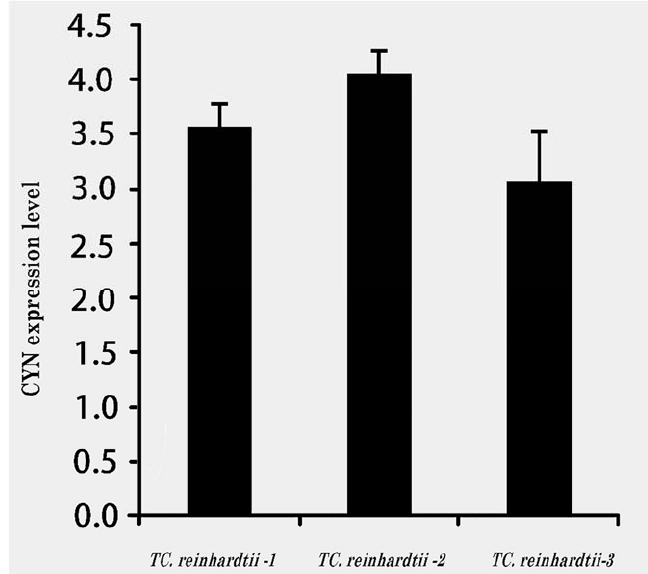
Figure 6. qRT-PCR analysis of CYN expression in three transgenic C. reinhardtii algae lines. Cycle threshold (Cts) value = 20.